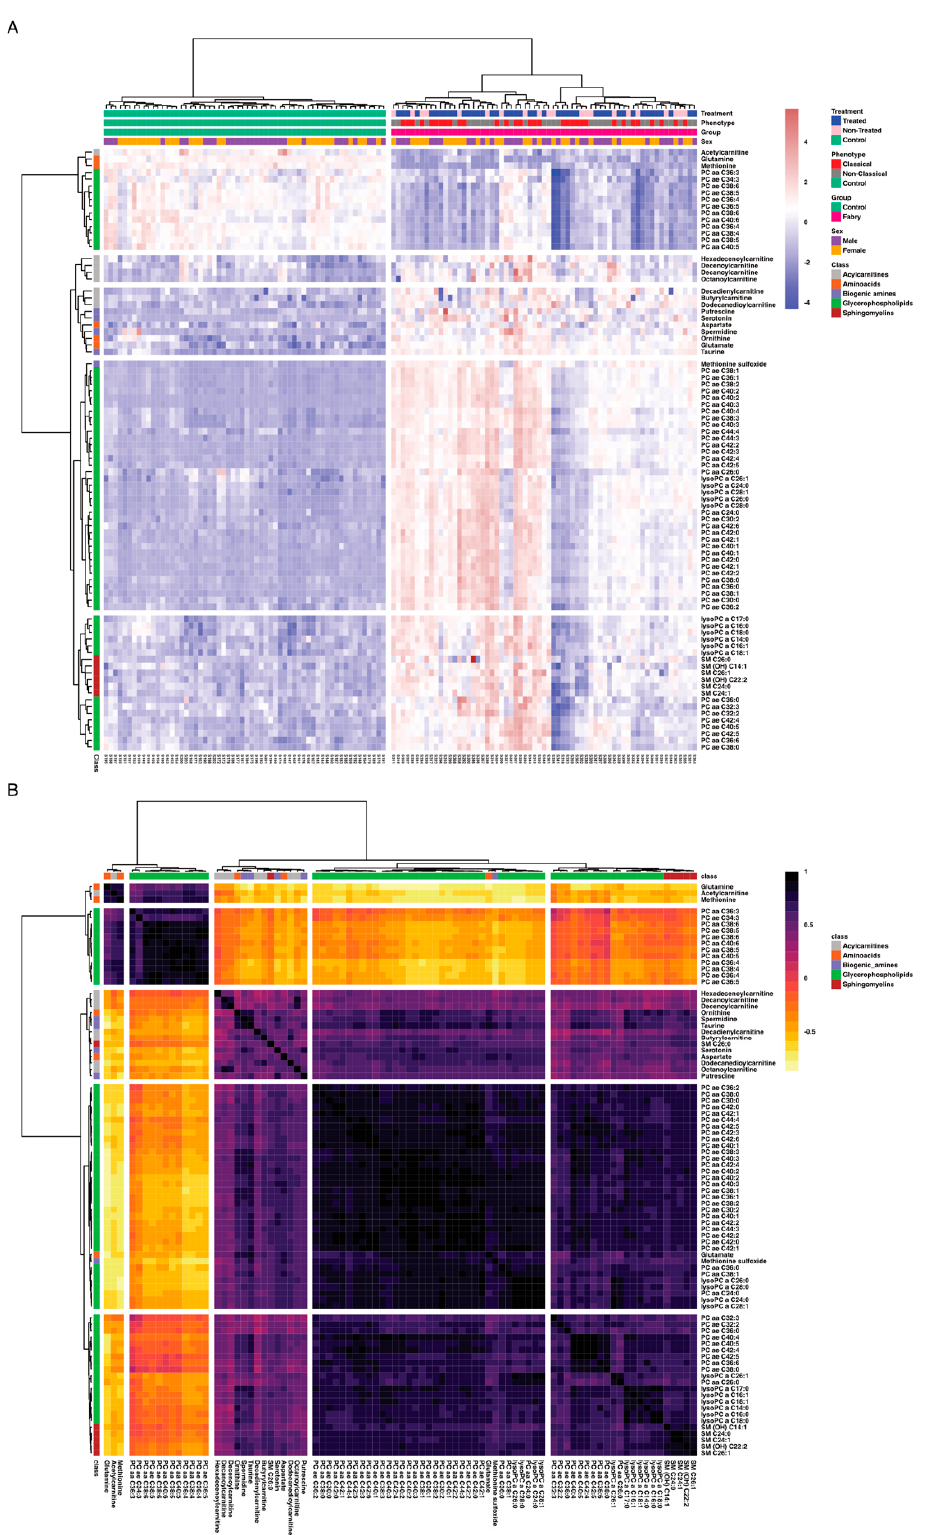
Figure 3. ( A ) Sample similarity heatmap. The colors refer to concentration z-scores. ( B ) Metabolites correlation heatmap. The color refers to Spearman correlation coefficients.